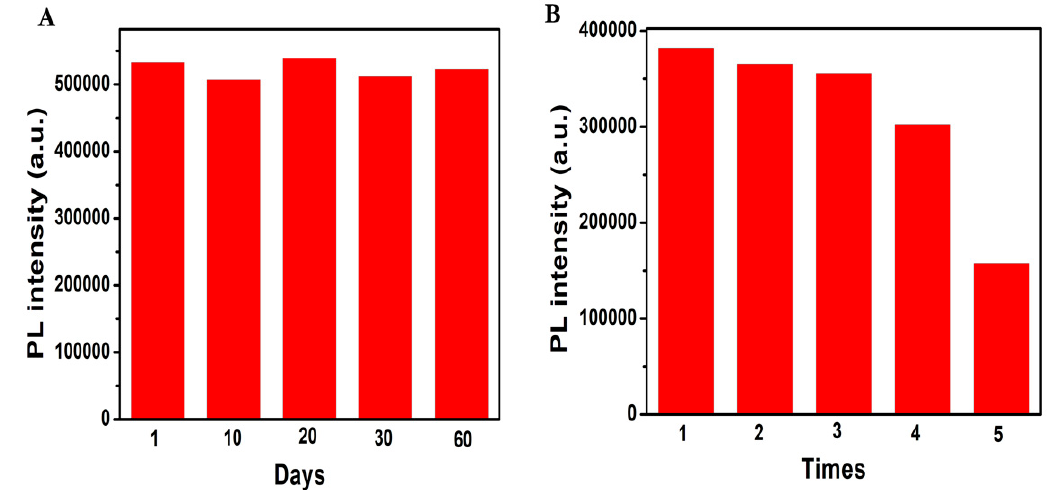
Figure 7. (A ) PL intensity of DMFN under di ff erent days and ( B ) PL intensity of DMFN under di ff erent recyclability times on the